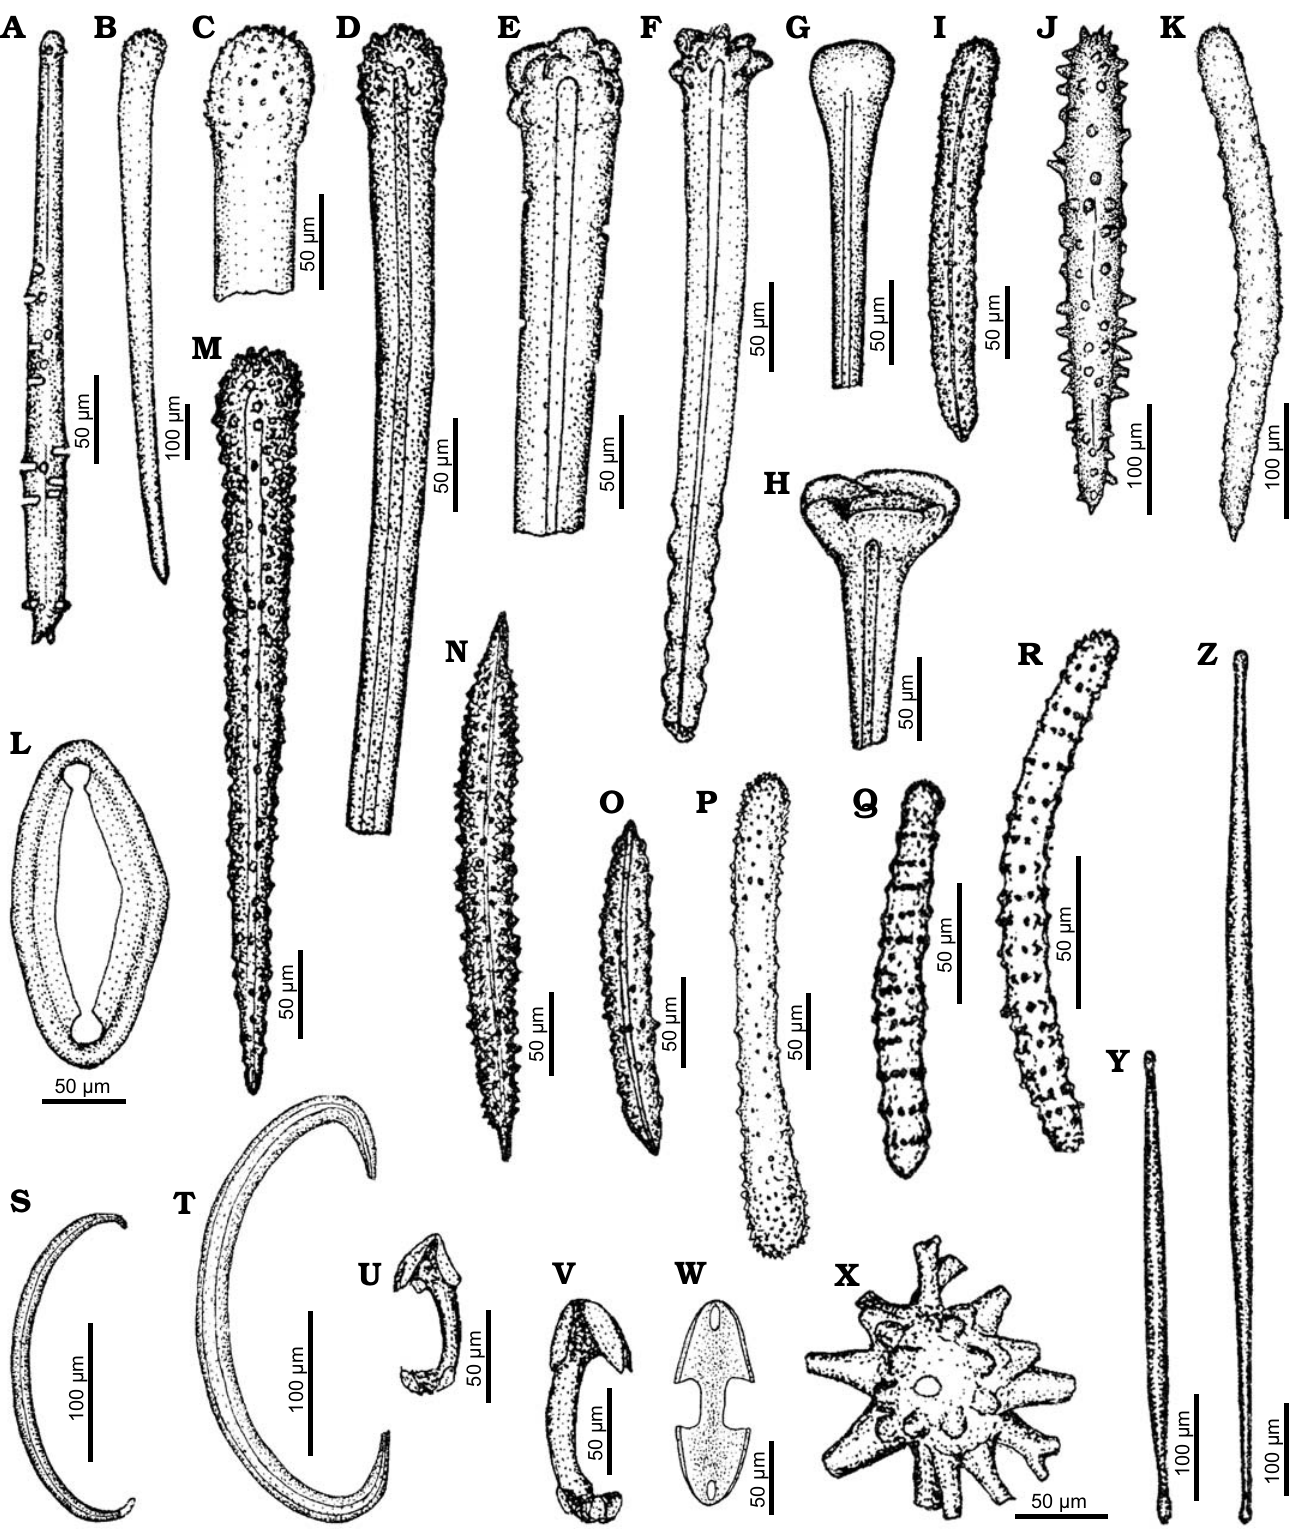
Fig. 6. Spicule morphotypes from south-central Ukraine; Russkie Ti ŝ ki, Middle Eocene (A, H, O, Y, Z), Kiselevka, upper Eocene (B, C), Markovka, middle Eocene (D), Russkie Ti ŝ ki, upper Eocene (E), Kiselevka, upper Eocene (F, G, M), Pogonovka borehole, upper Eocene (I), Markovka, upper Eocene (J, K,